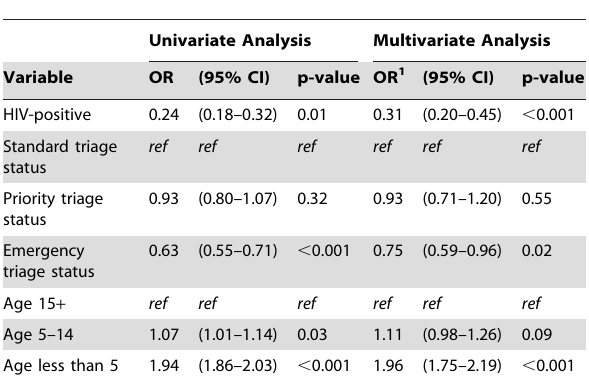
Table 2. Association between clinical exposure variables and inappropriate antibiotic treatment in patients without a clinical indication for antibiotics.